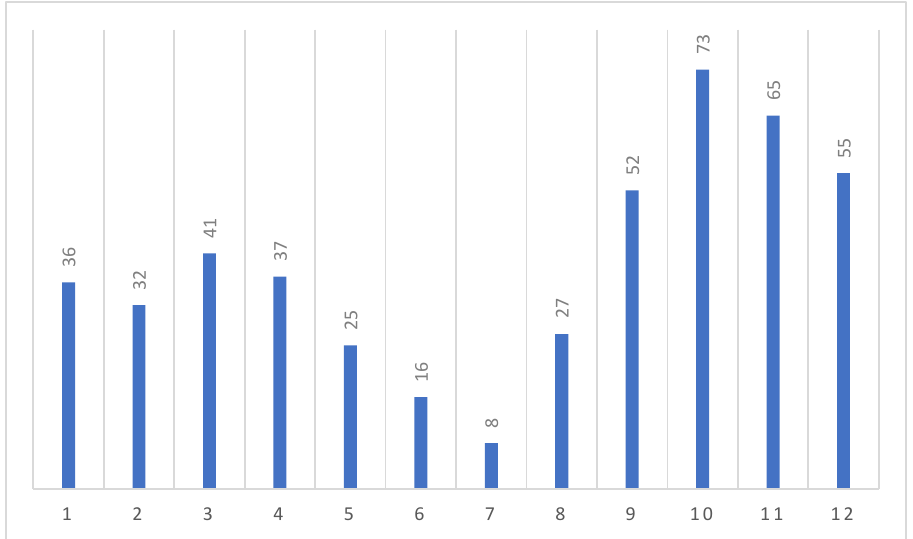
Figure 1. Monthly rainfall data (mm) averaged over the 1952–2015 period. Source: Institute of Statistics of the Balearic Islands [60] .